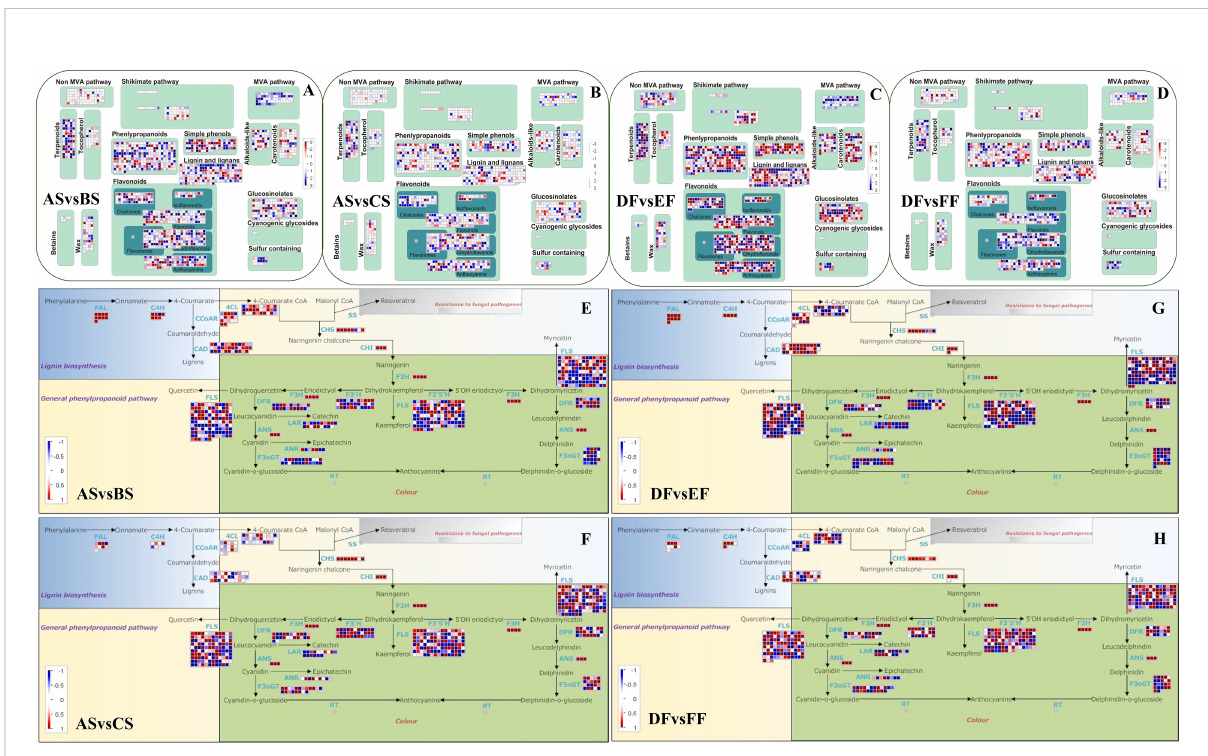
FIGURE 3 Effect of heat and cold treatment on the genes involved in general phenylpropanoid pathway and specialized metabolism in seeds and fruits of strawberry. The relative transcription levels of different genes in treated samples with heat and cold treatment compared to control were displayed in the heatmap. (A – D) represent the specialized metabolism in the comparison group of ASvsBS, ASvsCS, DFvsEF, and DFvsFF, respectively. The overview mainly consists of terpenoids, tocopherol, phenlypropanoids, simple phenols, lignin and lignans, fl avonoids, MVA pathway, alkaloids, carotenoids, glucosinolates, and sulfur containing. Blue color represents upregulation, while red color represents downregulation. (E – H) represent the phenylpropanoid pathway in the comparison group of ASvsBS, ASvsCS, DFvsEF, and DFvsFF, respectively. Blue represents downregulation, while red represents upregulation. PAL, C4H, 4CL, CCoAR, CAD, CHS, FLS, DFR, ANS, F3oGT, F3H, F3 ’ H, and F3 ’ 5 ’ H represent phenylalanine ammonialyase, cinnamate-4-hydroxylase, 4-coumaroyl-coA synthase, cinnamoyl-CoA reductase, cinnamyl alcohol dehydrogenase, chalcone synthase, fl avonol synthase, dihydro fl avonol reductase, anthocyanidin synthase, fl avonol-3-O-glucosyl transferase, fl avanone 3-hydroxylase, fl avonoid 3 ’ -hydroxylase, and fl aconoid-3 ’ ,5 ’ -hydroxylase, respectively. Samples were divided into two groups including seeds (RT (AS), heat (BS), and cold storage (CS)) and fruits (RT (DF), heat (EF), and cold storage